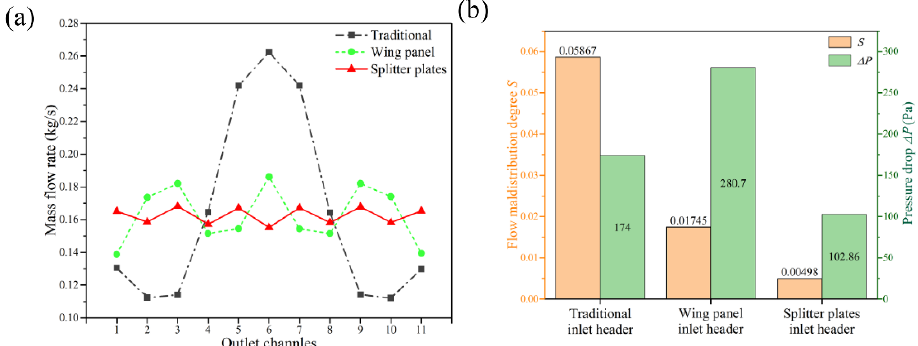
Figure 16. Comparison results: ( a ) Mass flow rates; ( b ) flow maldistribution degree and pressure drop.